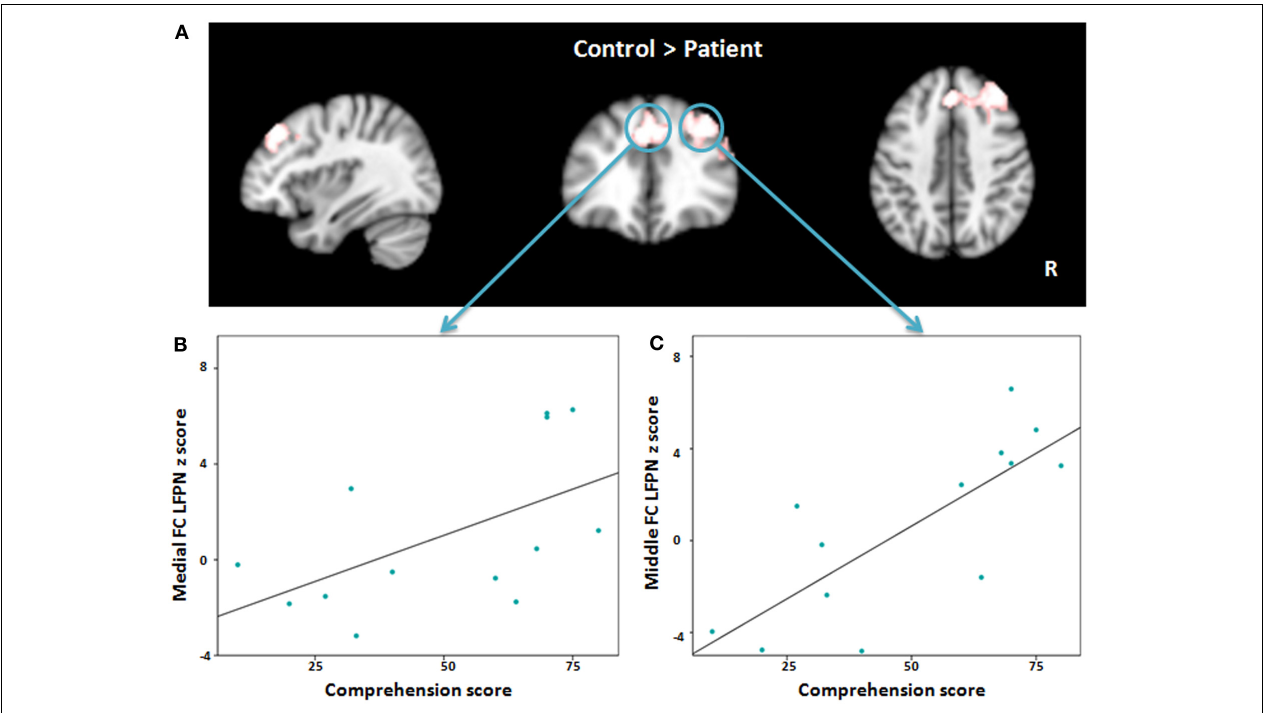
FIGURE 4 | (A) Red-white heat map represents results of decreased functional connectivity within left frontoparietal network in patients compared with controls. (B,C) Scatter plots depict the relationship between